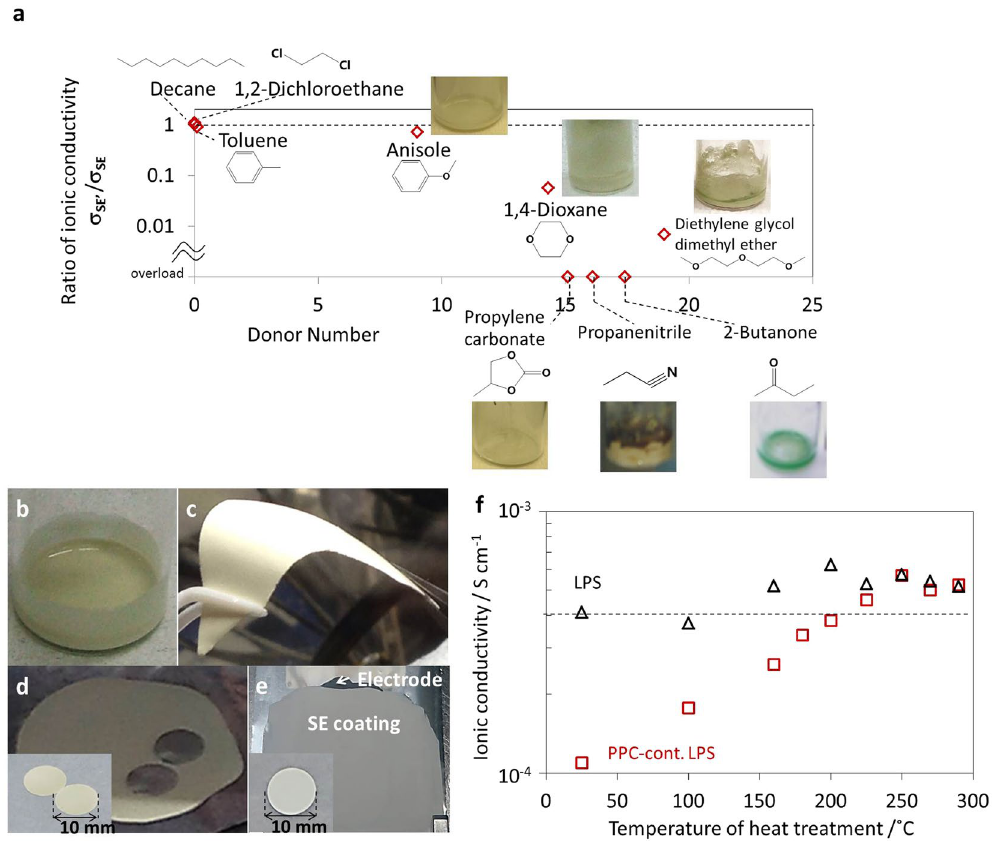
Figure 2. Exploration of solvent and aliphatic polycarbonate properties for the fabrication of binder-free sheet-type batteries. ( a ) Ionic conductivity of solvent-exposed LPS ( σ SE’ ) divided by that of pristine LPS ( σ SE ), i.e. σ SE’ / σ SE , as a function of the solvent’s donor number, where a higher donor number indicates higher nucleophilicity. Images of ( b ) a PPC-containing SE slurry, ( c ) a flexible and free-standing PPC-containing SE sheet (PPC; 6 wt.%, 8 vol%), ( d ) PPC-containing SE sheets punched by pressing a stainless-steel rod under 260 MPa and ( e ) a two-layered sheet prepared by coating the SE slurry on the electrode sheet. The inset is a two- layered sheet cut by punching machine. ( f ) Ionic conductivities of LPS and 6 wt.% PPC-containing LPS powder treated at various temperatures in the range from 25 to 290